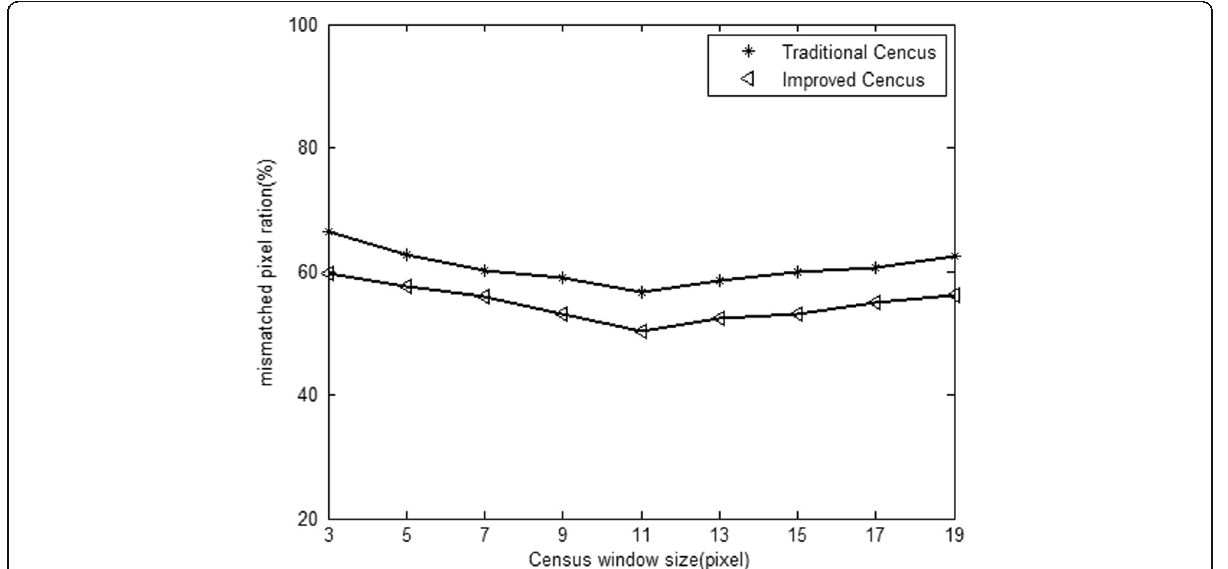
Fig. 6 Influence of different Census transform window sizes on matching quality under noise